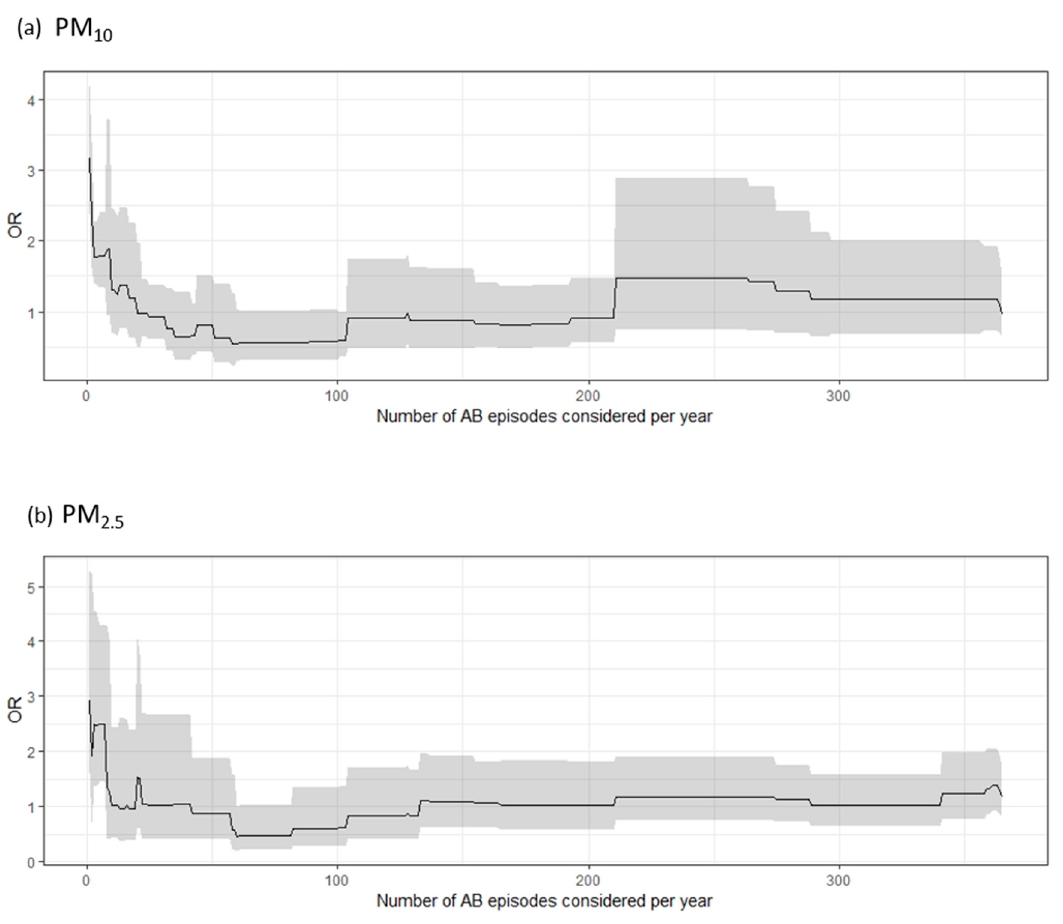
Figure 2. Increasing number of atrial burden (AB) episodes considered in the analysis and relative OR and confidence interval (in gray) for particulate matters of less than 10 µ m (PM 10 ) ( a ) and less than 2.5 µ m (PM 2.5 ) ( b ) in aerodynamic diameter. Table 4. Firth’s logistic regression with delayed e ff ects in time analyzed with a distributed lag model. Pollutant E ff